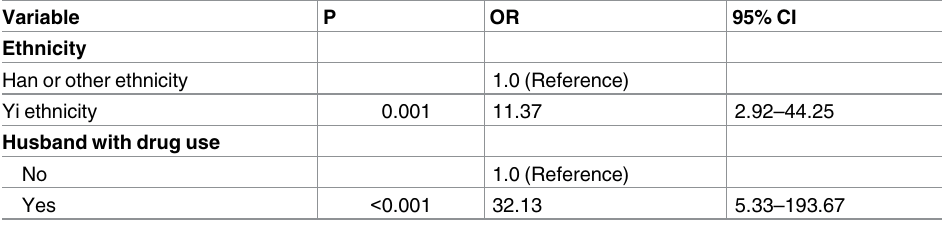
Table 2. Multivariate logistic regression analysis of factors associated with HIV positivity in pregnant women of